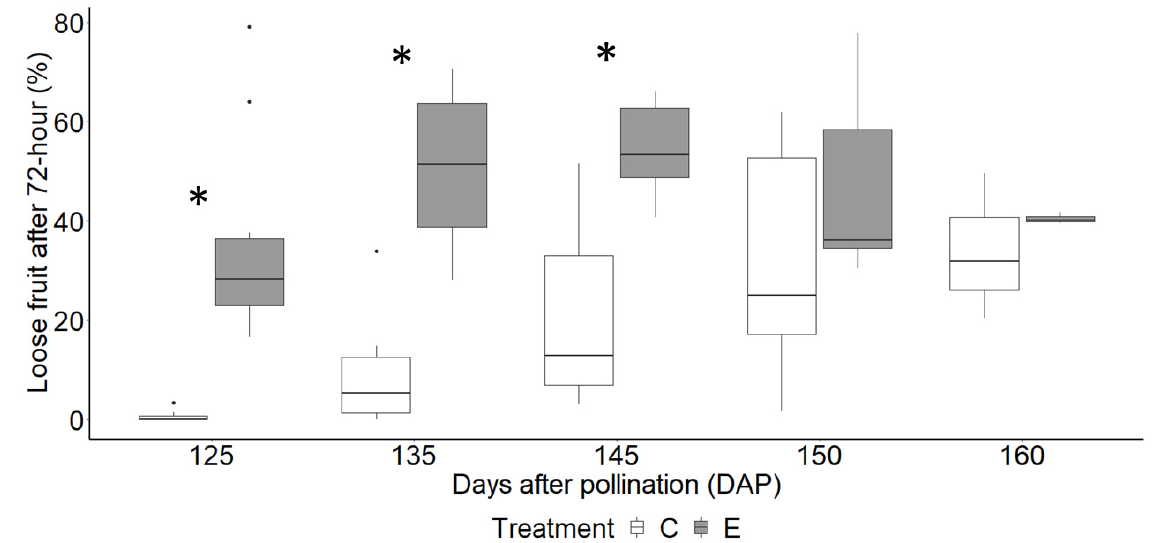
Figure 3. The boxplots represent median values, 25th–75th percentile of loose fruit percentage of ethephon-treated (E) and control (C) FFB after 72-h incubation across FFB ripeness. Significant difference in loose fruits between E and C are denoted by asterisk (*) based on the Kruskal–Wallis test at the p = 0.05 threshold.